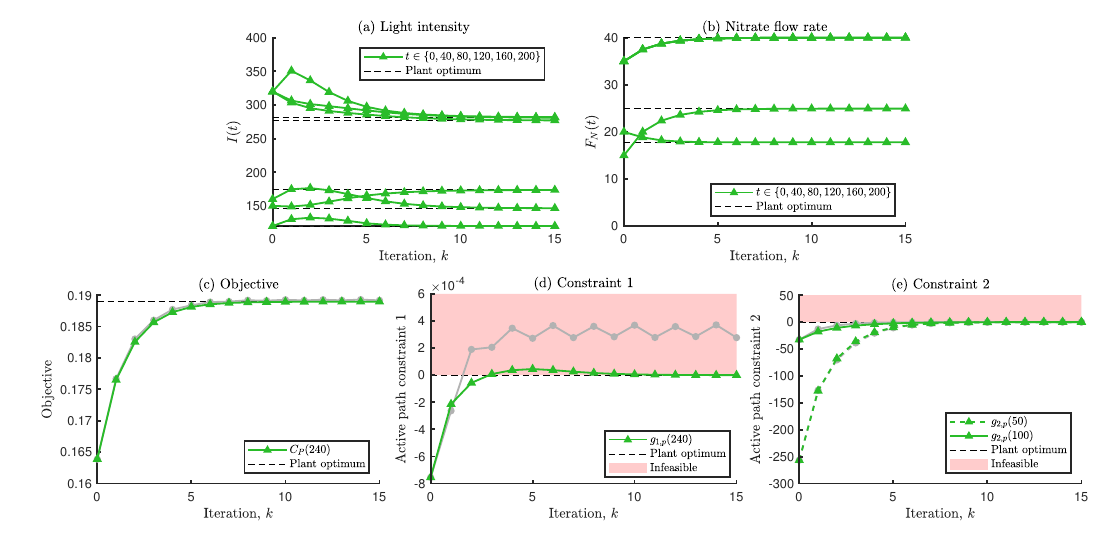
Figure 16. Multi-solution MA inputs and NLP functions using the closest solution approach shown as the green triangle line. Top row, inputs. Bottom row, objective and constraints which are active at plant optimum, where the standard MA approach is shown as the grey circle